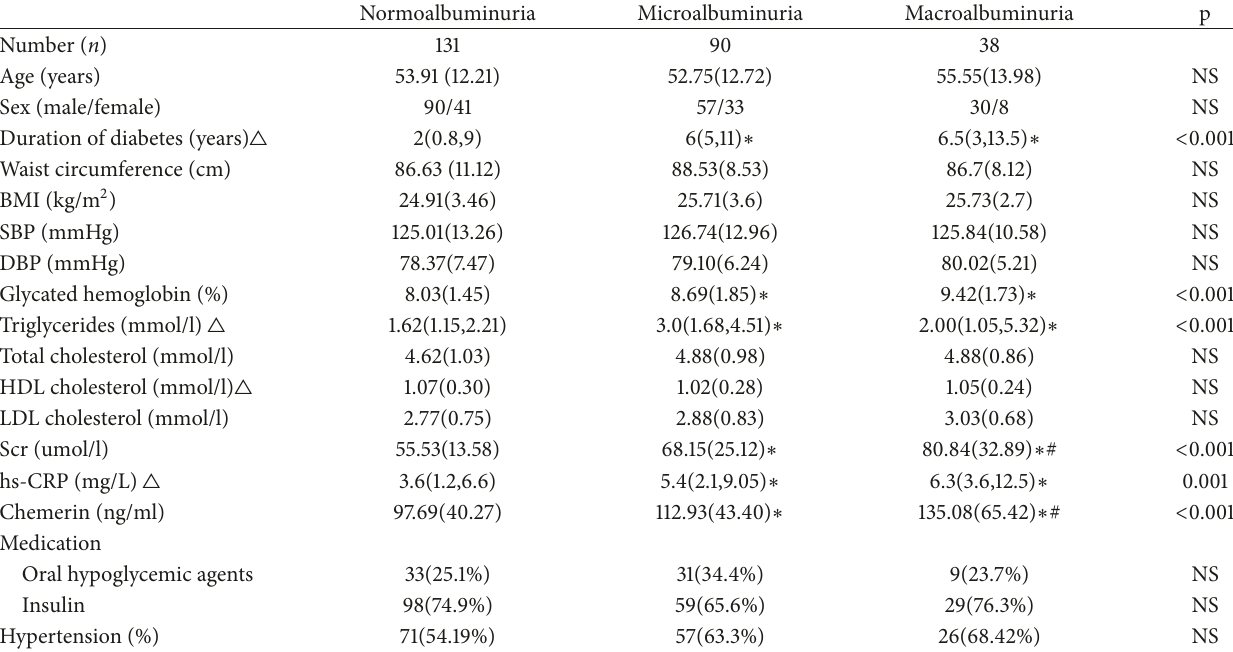
Table 4: Clinical characteristics in type 2 diabetic patients with normoalbuminuria, microalbuminuria, and